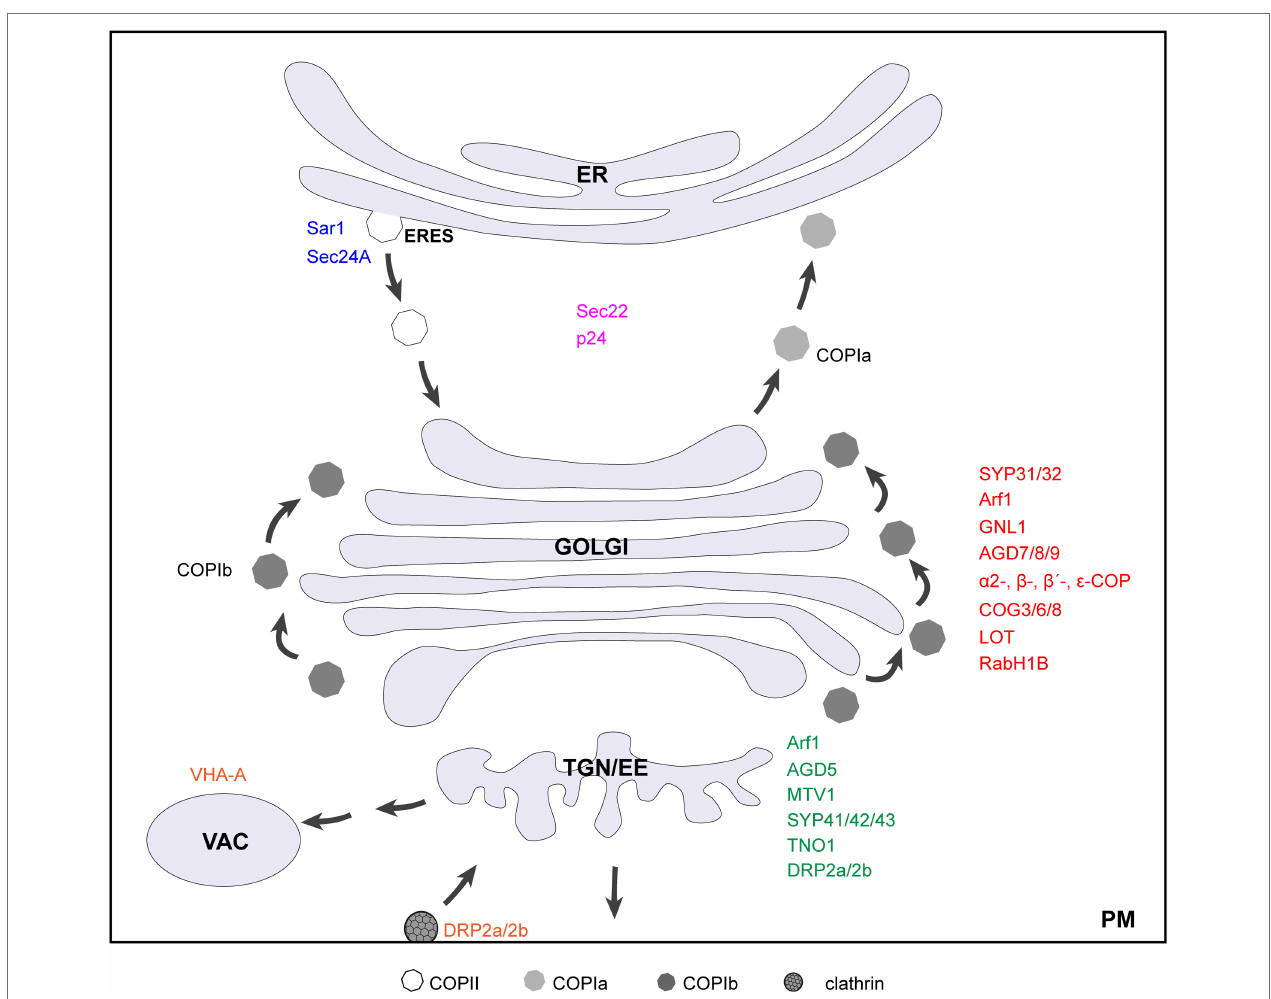
FIGURE 1 | Diagram of a cell showing key genetic elements involved in plant Golgi structure maintenance. Factors that localize to ERES, Golgi, TGN, and vacuole/ PM are indicated in blue, red, green, and orange, respectively. The proteins recycle between ER and Golgi are indicated in purple. Note that DRP2a/2b also have functions at the plasma